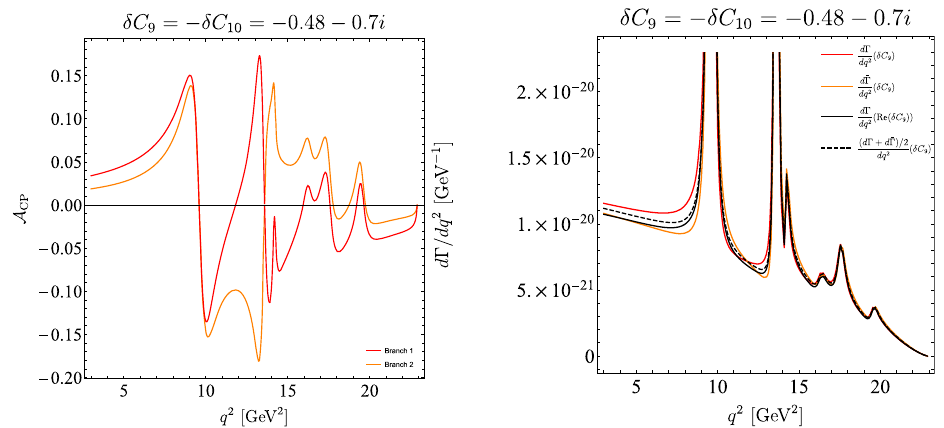
Fig. 4 In the left panel we plot A CP ≡ A CP ( q 2 ) in the full physical averaged differential decay rate in this scenario to show that the effect of δ C 9 ∈ C is extremely difficult to disentangle from this quantity. region, and for the benchmark point in the BSM scenario satisfying δ C = − δ C Indeed, the (dashed) curve corresponding to the CP-average of decay 9 10 . Two branches correspond to two sets of solutions for widths and Im (δ C 9 ) = − 0 . 7 is hardly distinguishable from the full strong phases obtained from the fit to the data of Ref. [16]. Other two black curve in which Im ( δ C 9 ) is set to zero. Here the “branch1”set of branches would correspond to flipping the sign of the above-depicted ( q 2 ) in the region q 2 (cid:2) m 2 A resonant parameters has been CP ψ( 2 S ) . In the right panel we plot the CP-